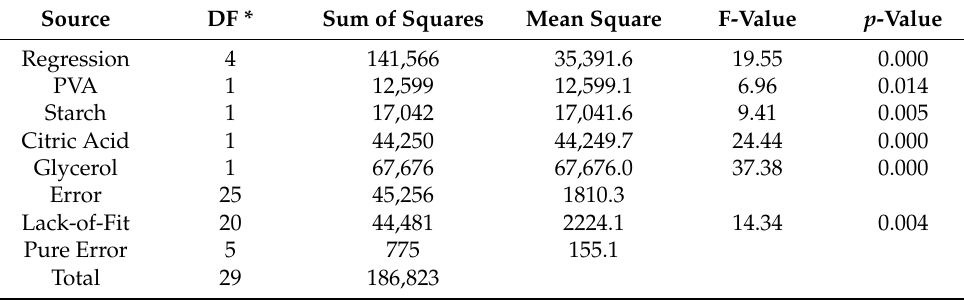
Table 2. Swelling index output data, with a summary of the